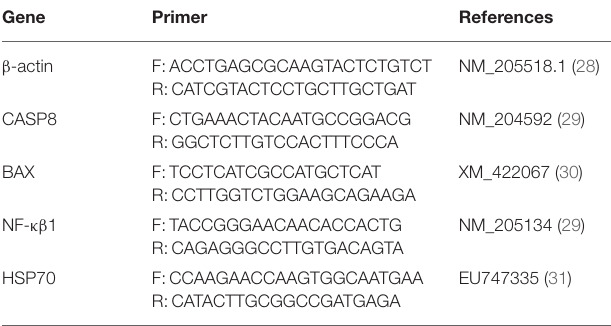
TABLE 2 | Primer sequences (5 ′ -3 ′ ) used in real-time